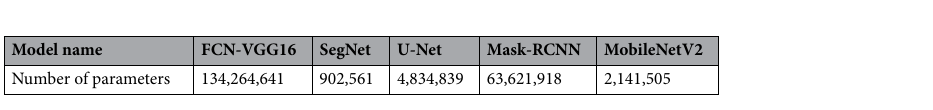
Table 3. Comparison of total numbers of trainable